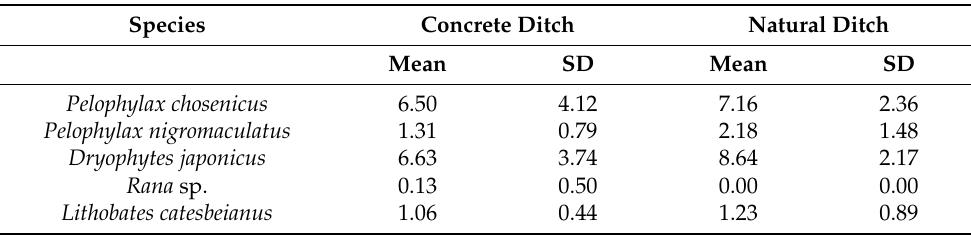
Table 1. Descriptive statistics for species occurrence during field surveys. The surveys were con- ducted in North Jeolla Province, Republic of Korea, between May and June from 2014 to 2016. The data are split between concrete drainage ditches and natural ditches in the vicinity of rice paddies.